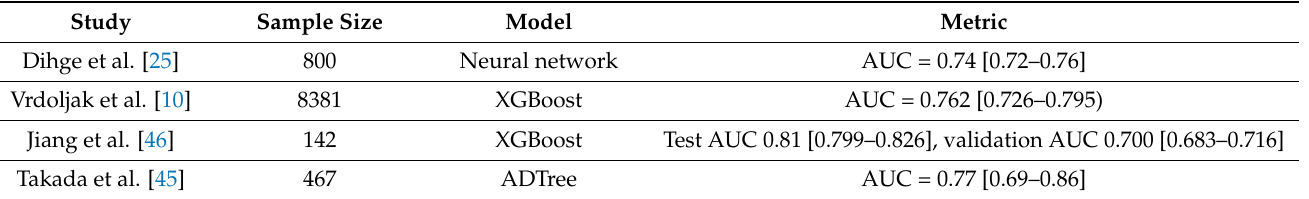
Table 4. Summary of studies using clinicopathological features for breast cancer lymph node